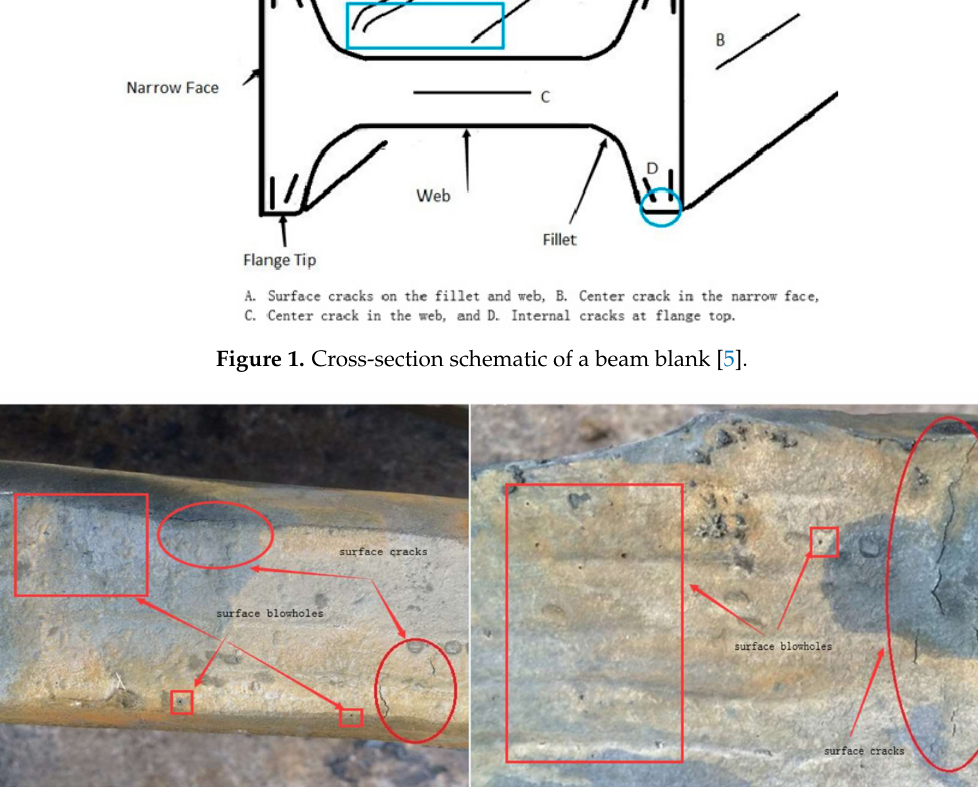
Figure 2. Surface cracks and blowholes on ( a ) web and ( b ) fillet of actual beam blank [5].